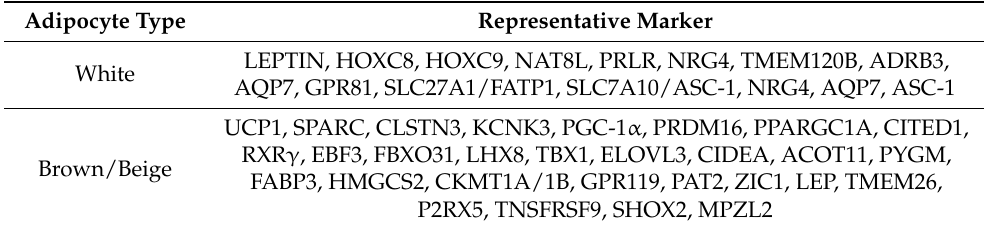
Table 1. Representative markers for distinguishing white and brown/beige